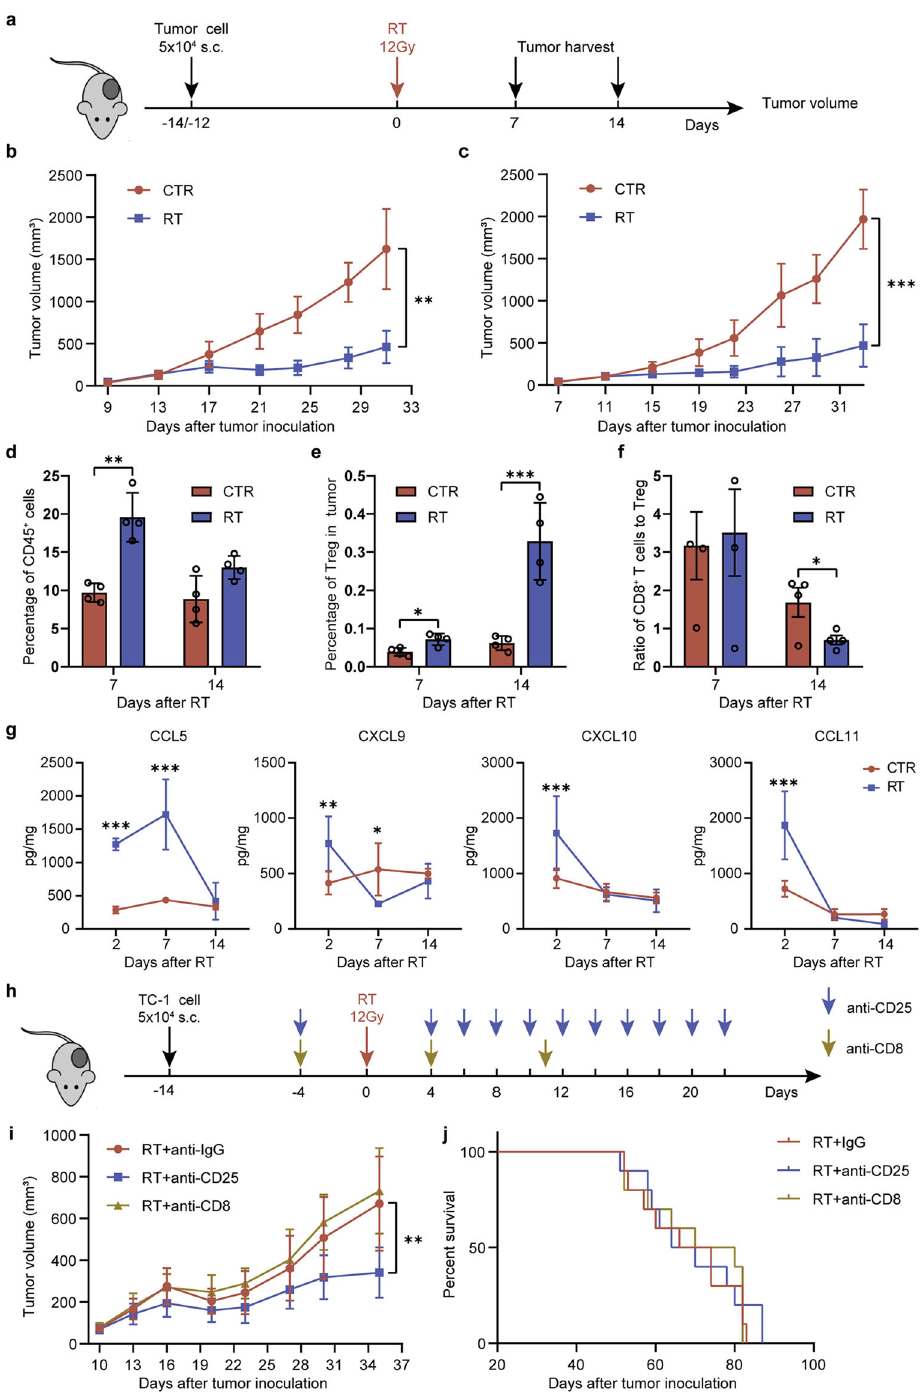
Fig. 2 Tregs induced by RT were in charge of tumors relapse. a Experimental procedure. b Tumor growth curves of TC-1 and c 4T1-Luc 2 tumor models. n = 10 mice/group. d – f Flow cytometry analyses in TC-1 tumors. d Percentage of dynamic changes of CD45 + cells in tumors with time. e Percentage of dynamic changes of Tregs (CD45 + CD4 + CD25 + Foxp3 + ) in tumor with time. f Ratios of CD8 + T cells to Tregs in tumors with time. g The level of chemokines in TC-1 tumor (pg/mg protein of tumor tissue). Data are presented as mean ± SD; n = 3 to 4 mice/group. h Experiment procedure for antibodies depletion. i TC-1 tumor growth curves of the mice treated with or without antibodies depletion. j Survival curves of the mice bearing TC-1 tumors treated with or without antibodies depletion. n = 9 mice/group. Experiments were repeated two times and two-tailed t -test was used for two-way comparisons of biological replicates. * P < 0.05, ** P <